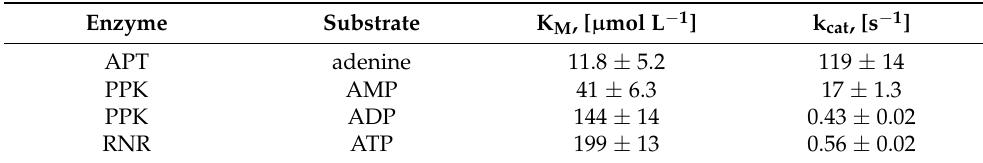
Table 2. Kinetic parameters of the enzymes : The kinetic parameters K M and k cat were determined for each enzyme and reaction step. Since the PPK catalyzes two reaction steps, the kinetic parameters were determined for each